Question: Looking at the figure, what chart type is it?
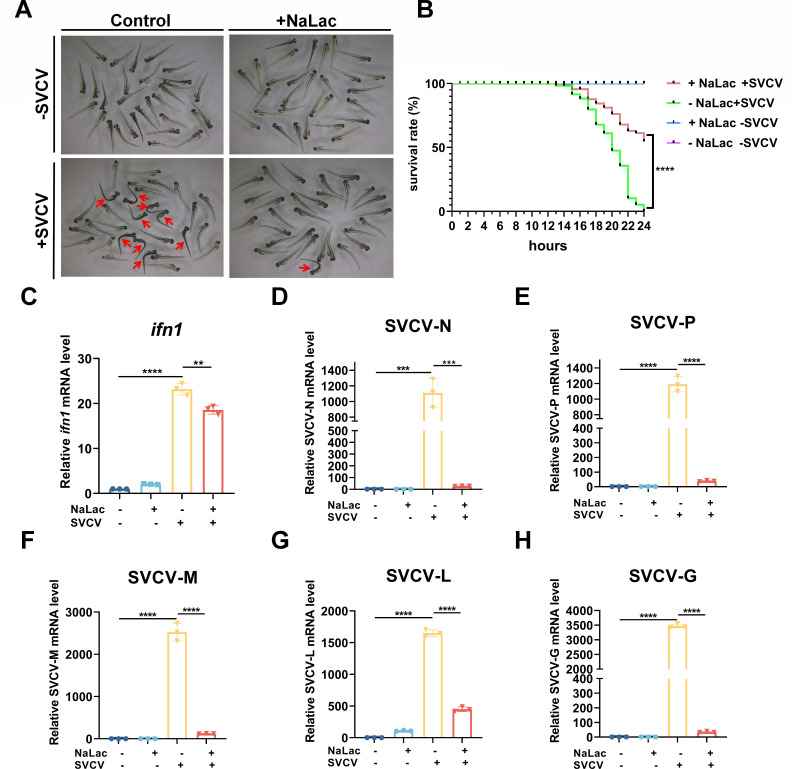
Answer: survival